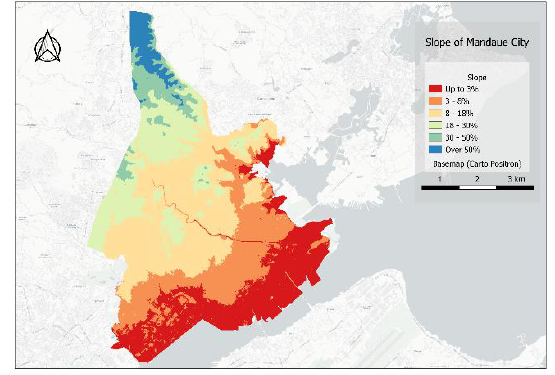
Figure 5. Slope map of Mandaue City, Cebu